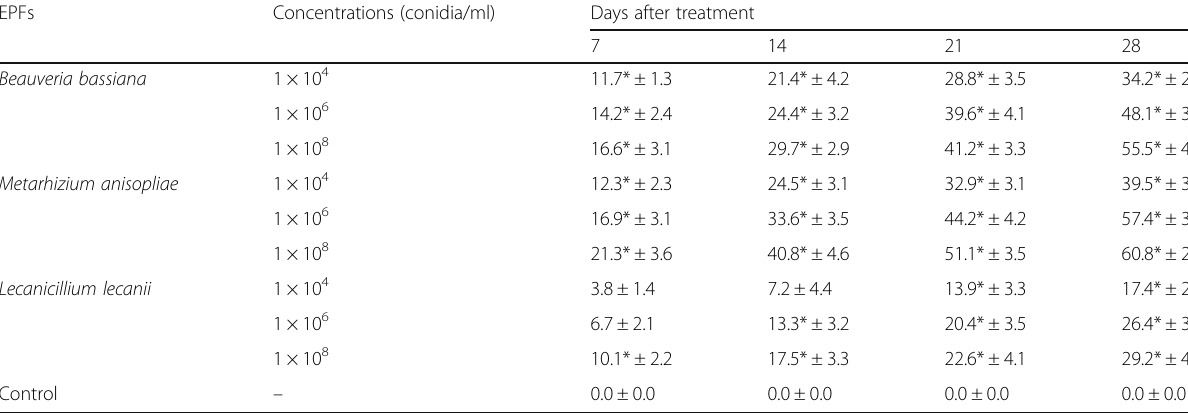
Table 1 Mortality percentages (% ± SE) of the third instar Oryctes agamemnon larvae treated with entomopathogenic fungi (EPFs) Beauveria bassiana , Lecanicillium lecanii , and Metarhizium anisopliae EPFs Concentrations (conidia/ml) Days after treatment Beauveria